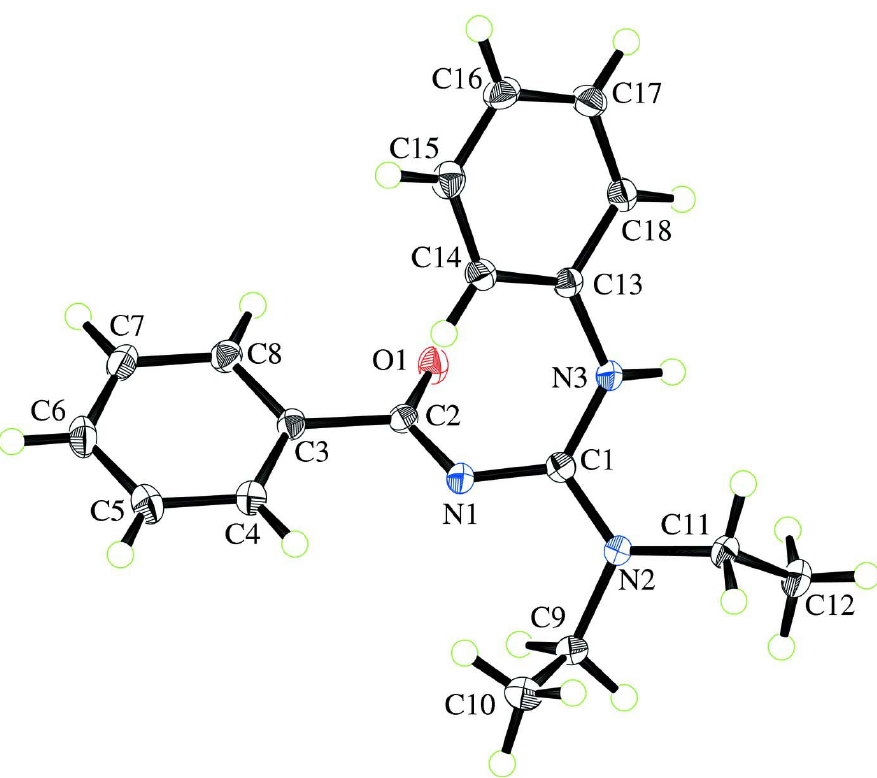
Figure 1 Molecular structure of compound (I), showing the atom numbering scheme. Displacement ellipsoids are drawn at the 50% probability